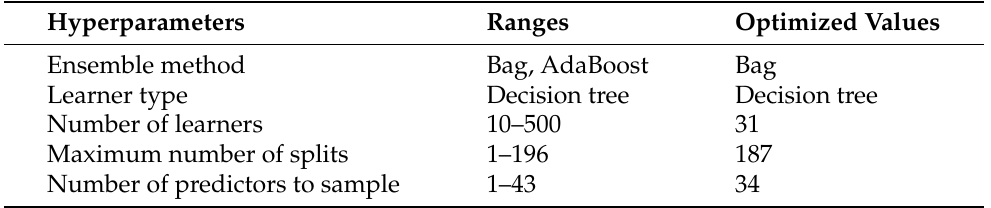
Table 4. Hyperparameters of the trained ensemble bag tree